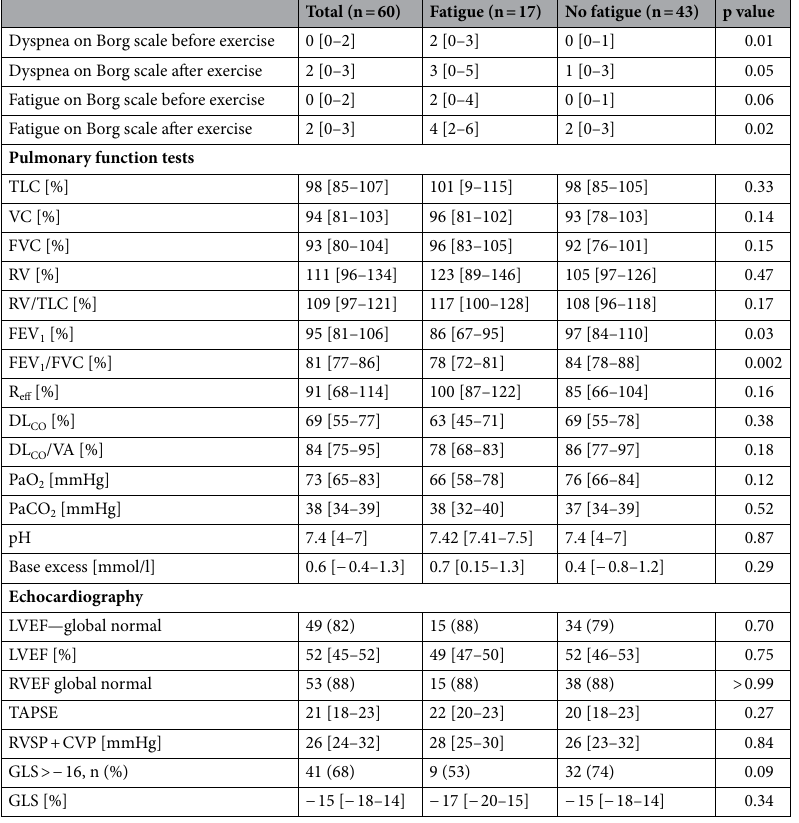
Table 2. Follow-up parameters at 6-month time-point. Values are presented as mean ± standard deviation, number of patients (percentage) or median [interquartile range]. BMI, body-mass-index; BP, blood pressure; LDH, lactate dehydrogenase; CK, creatine kinase; hs-Troponin T, high sensitive troponin-T; NT pro BNP, N-terminal pro B-type natriuretic peptide; CRP, C-reactive protein; PCT, Procalcitonin; PHQ-9, Patient Health Questionnaire 9; GAD-7, Generalized Anxiety Disorder 7; SGRQ, St. Georges’s Respiratory Questionnaire; EQ-5D-5L, Euro Quality of Life-Five Dimensions-Five Levels; 6MWT, six- minute walk test; HR, heart rate; TLC, total lung capacity; VC, vital capacity; RV, residual volume; FEV 1 , forced expiratory volume in 1s; FVC, forced vital capacity; R eff , effective specific resistance; DL co , diffusing capacity for carbon monoxide; VA, alveolar volume; PaO 2 , partial pressure of oxygen; PaCO 2 , partial pressure of carbon dioxide; LVEF, left ventricular ejection fraction; RVEF, right ventricular ejection fraction; TAPSE, tricuspid annular plane systolic excursion; RVSP, right ventricular systolic pressure; CVP, central venous pressure; GLS, global longitudinal strain.